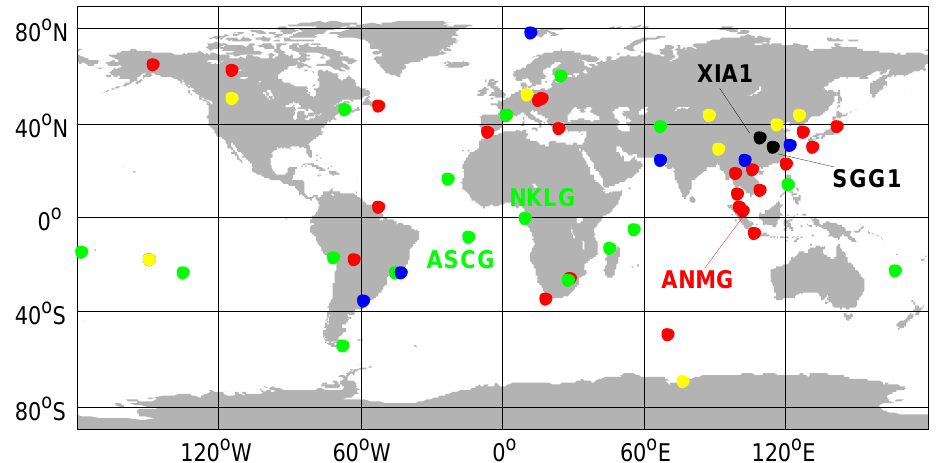
Figure 6. Geographical distribution of 60 stations. Both the red and green points refer to the MGEX stations, and can offer B1/B2 and B1/B2/B3 BDS-2 tracking, respectively. Both the yellow and blue points refer to the iGMAS stations, and the former are able to offer both B1/B2/B3 BDS-2 and B1/B3 BDS-3S tracking, while the latter can only offer B1/B2/B3 BDS-2 tracking. The black points refer to the stations with the capability of tracking the new navigation signals. The stations indicated by the station name will be used as illustrations in the manuscript.